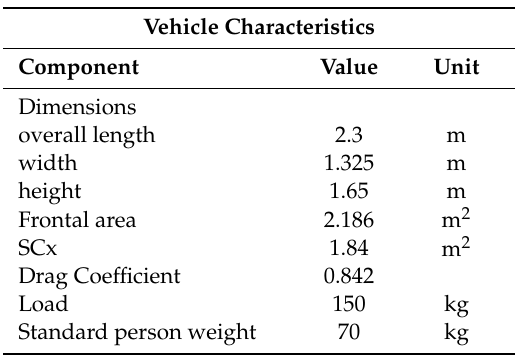
Table 1. Simulation data. Table 1 . Simulation data.